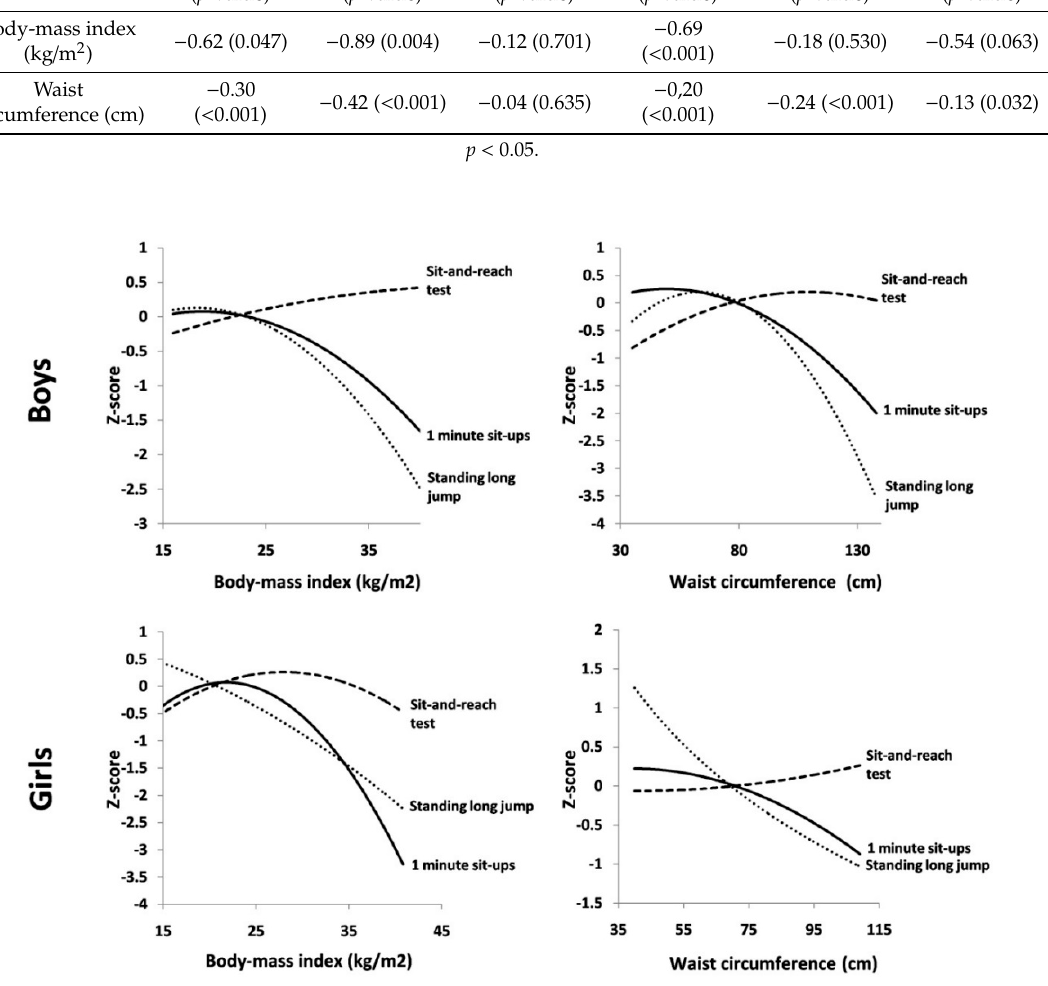
Figure 1. Quadratic associations between anthropometric indices and physical fitness in boys and girls, Croatia (2019).